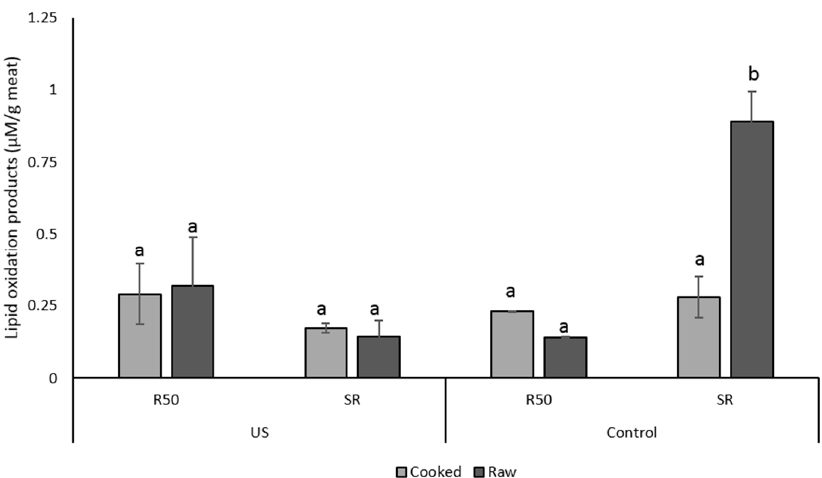
Figure 3. Formation of secondary lipids oxidation products in chicken marinated with NaCl / KCl (SR) or reduced-salt marinade (R50); Chicken samples were marinated with a US frequency of 130 kHz for 1 h. Values are compared with chicken samples marinated without ultrasound for 16 h (Control). Values represents means ± standard deviation (SD, N = 4). Different letters are significant at p < 0.05.